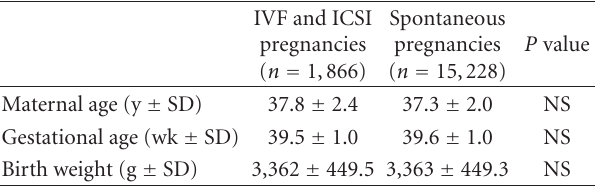
Table 1: Patient